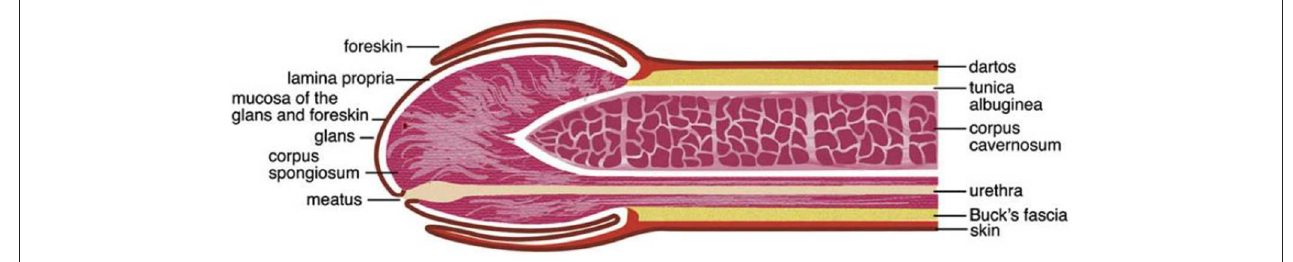
FIGURE 1 | Anatomy of the human penis. The figure is taken from the review entitled “Benign Diseases and Neoplasms of the Penis” by Wasco and Shah (26), with permission to reproduce